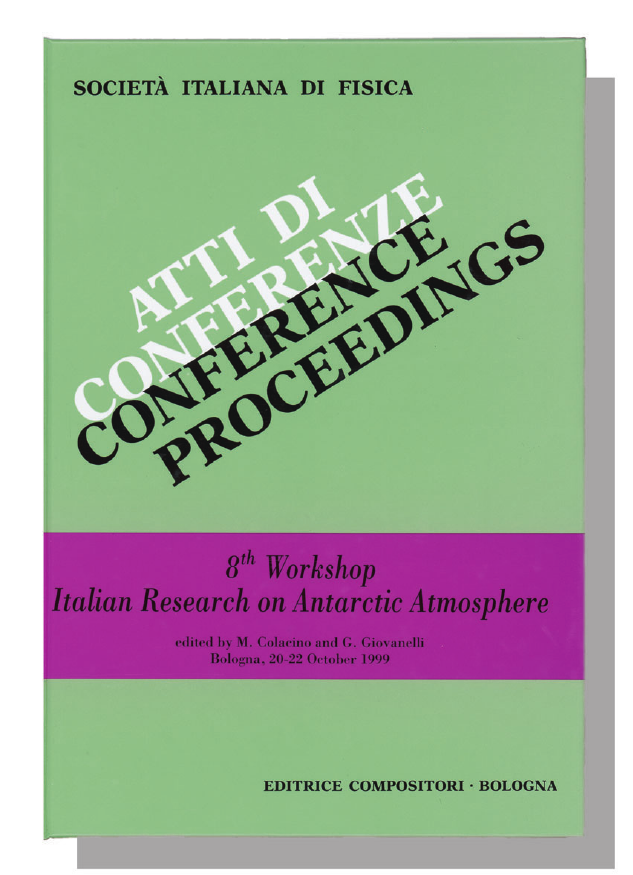
Fig. 6. Cover of the last volume of Proceedings of Workshop on Antarctic Atmosphere Research (Colacino and Giovanelli,